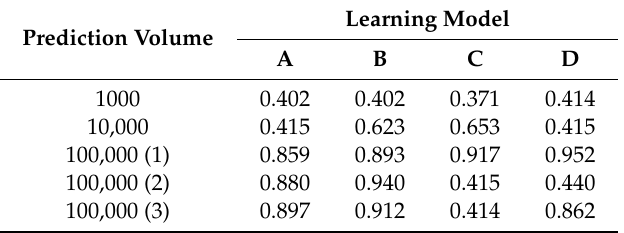
Table 8. Prediction accuracy of model based on ANN learning volume.